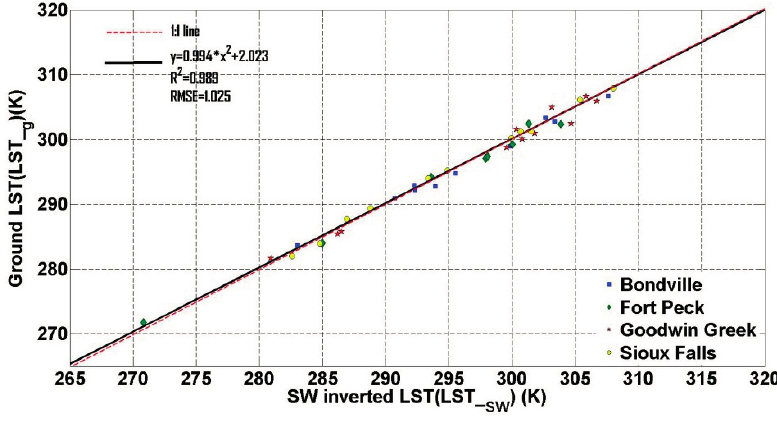
Figure 3. Comparison between SW inverted LST and ground